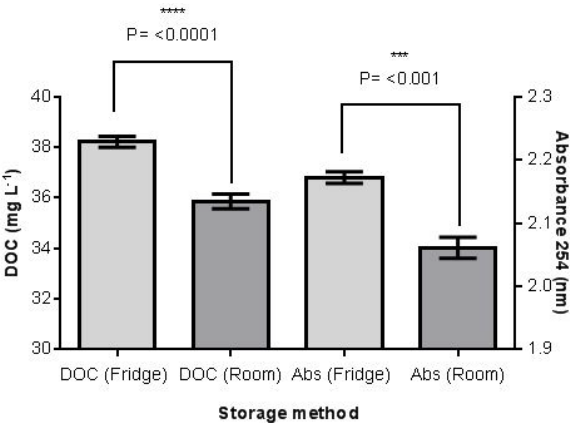
Figure 1. Average DOC concentrations and absorbance at 254 nm for the two storage methods in Experiment 1. Error bars indicate the standard error of the mean. The degree of statistical significance between the two methods (paired two- tailed t-test) is also shown ( n =